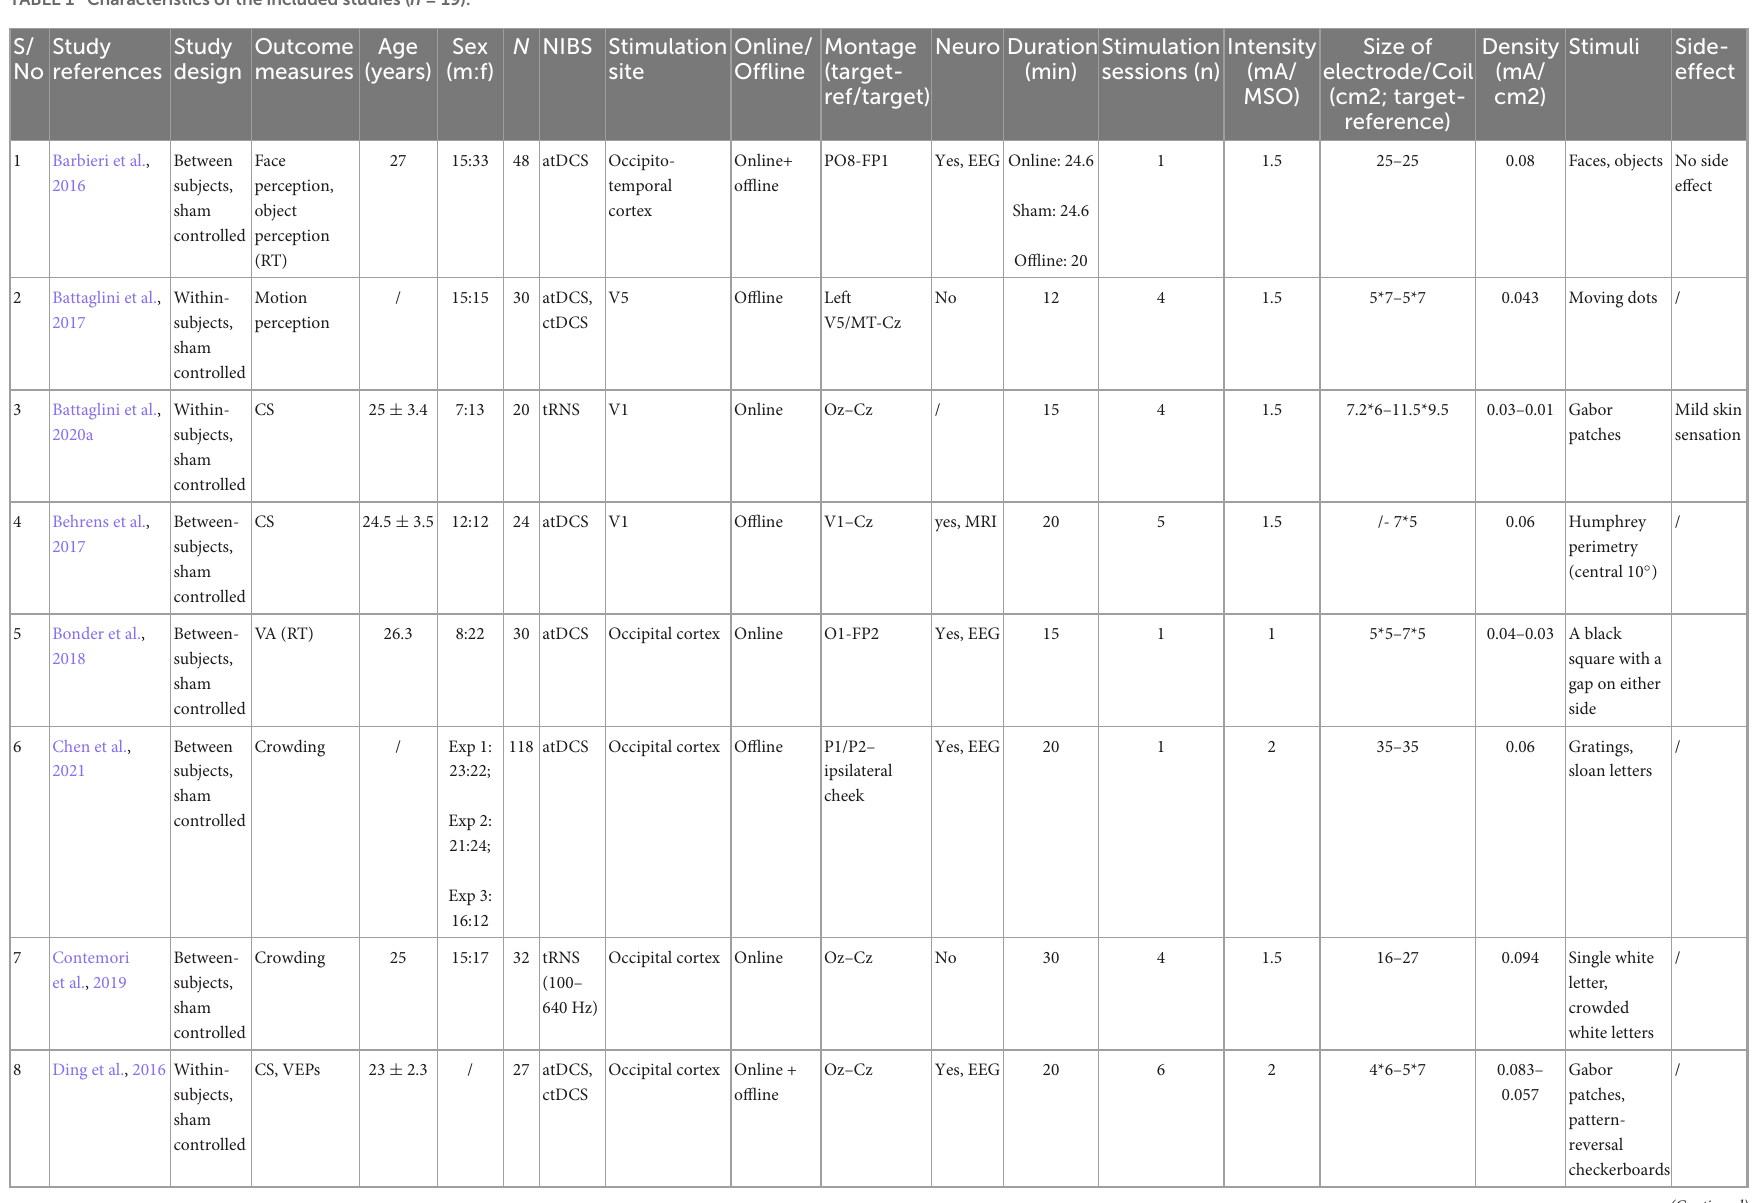
TABLE 1 Characteristics of the included studies ( n =